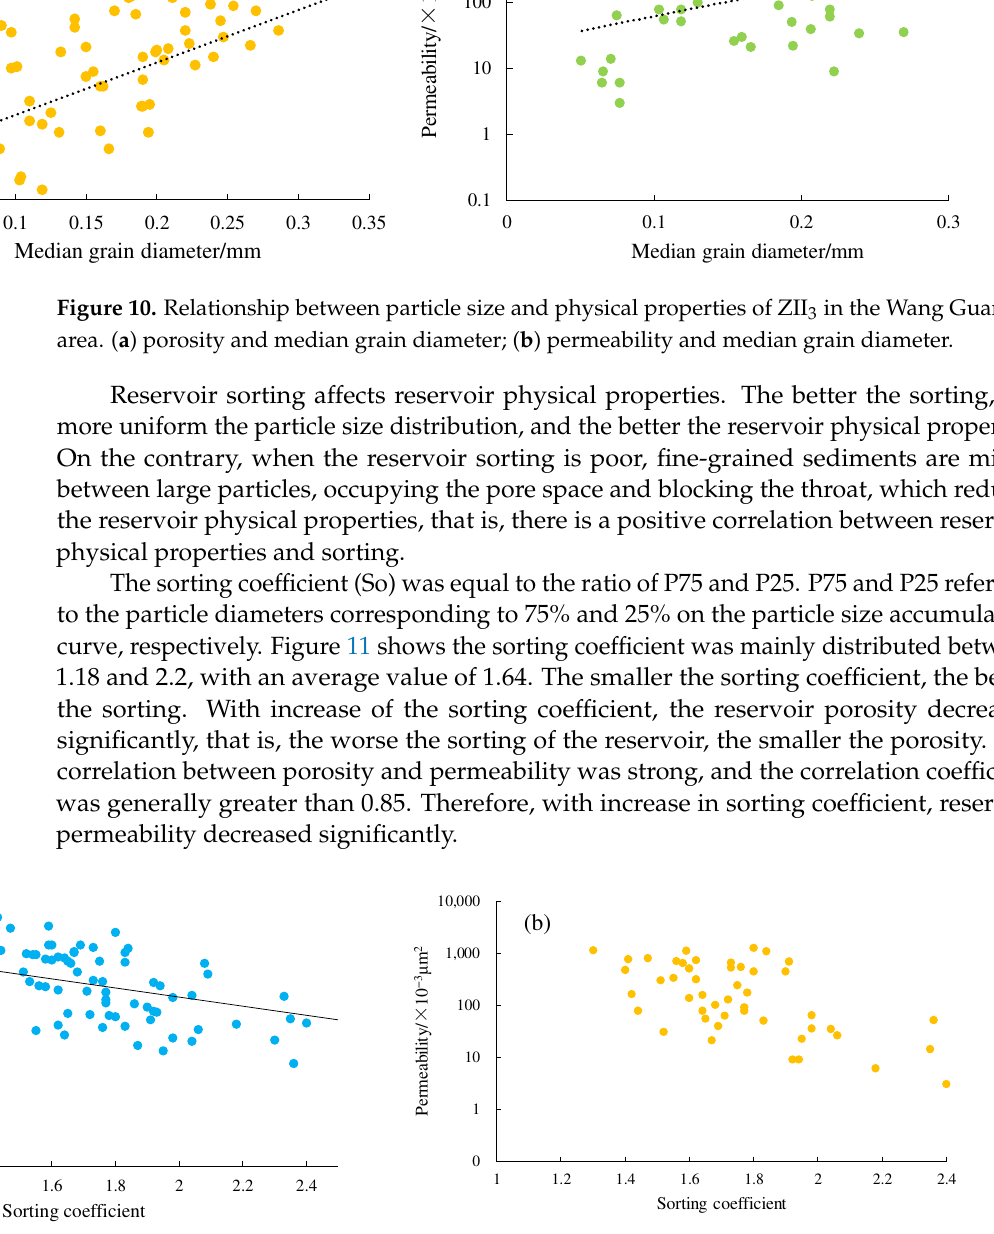
Figure 11. Relationship between sorting and physical properties of ZII 3 in the Wang Guantun area. ( a ) porosity and sorting coefficient; ( b ) permeability and sorting coefficient.